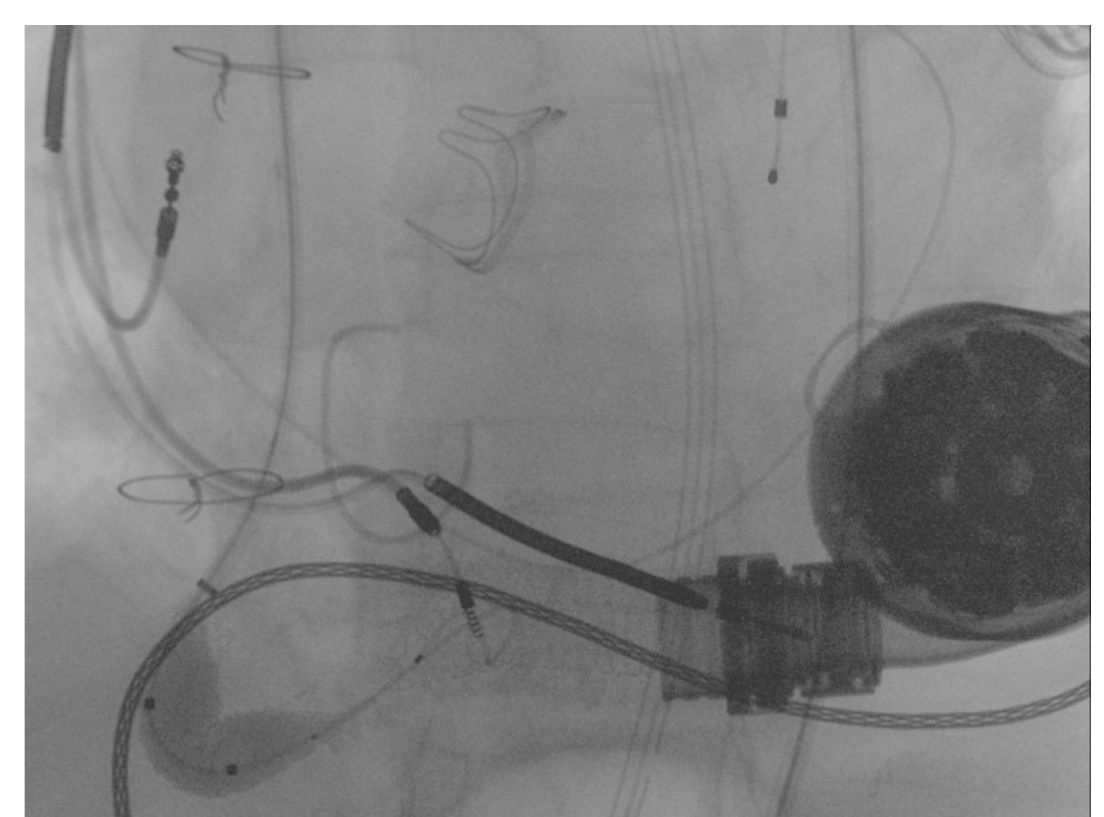
Figure 4. Postdilation of the implanted stent.